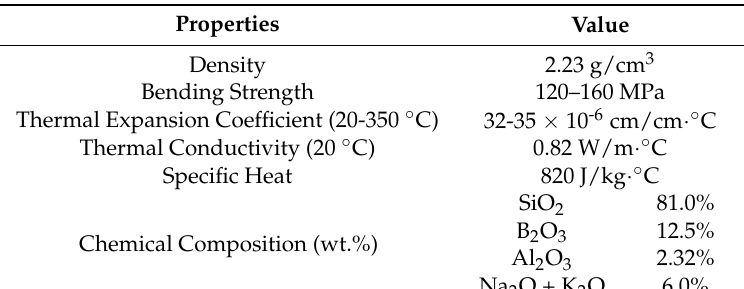
Table 1. Properties of borosilicate glass.